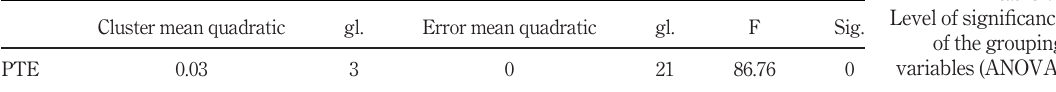
Table 7. Level of signi fi cance